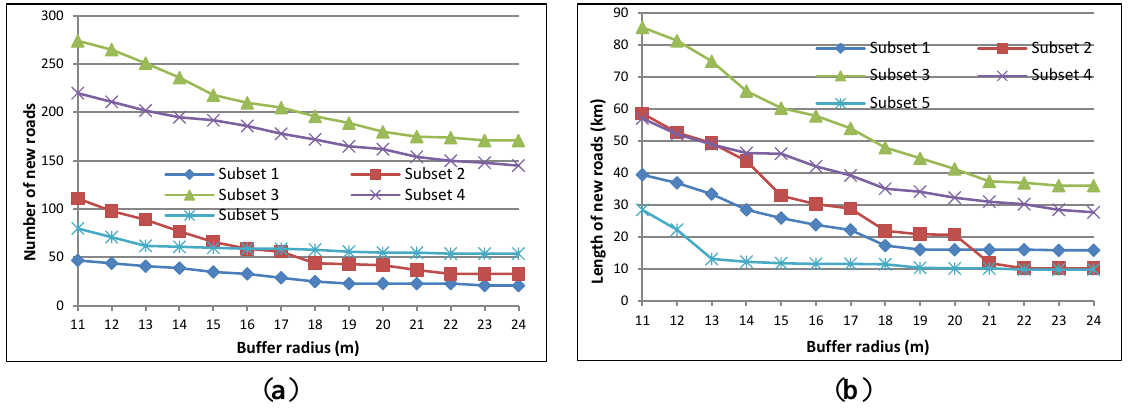
Figure 8. Plots of detected number of new roads ( a ) and their lengths ( b ) vs. the buffer radius for five 5 km × 5 km subsets in